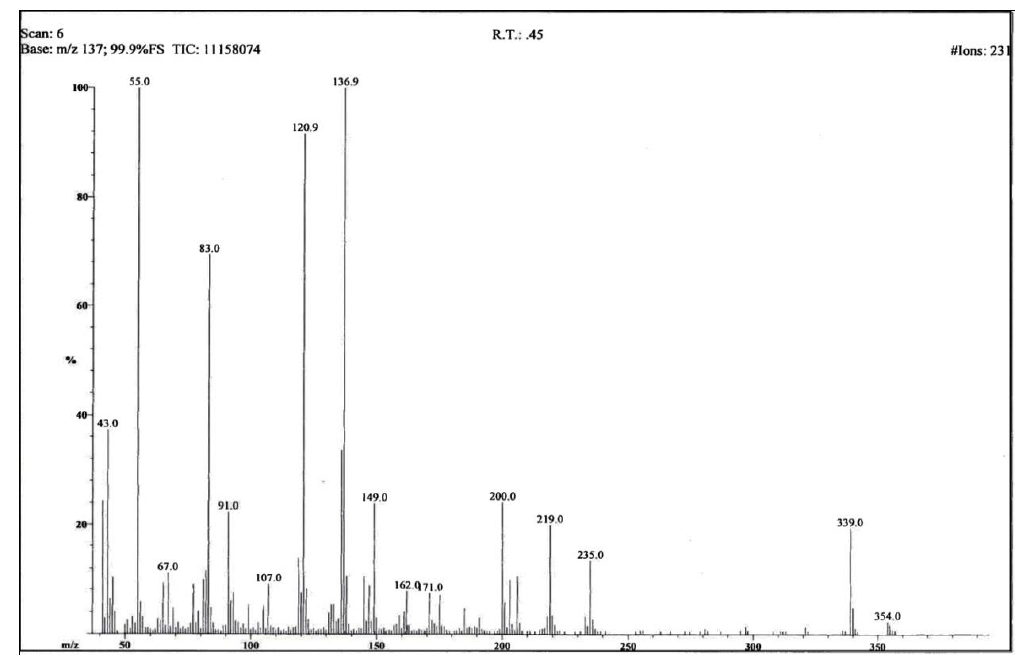
Figure S2: E.I mass spectrum of diketone monomer o